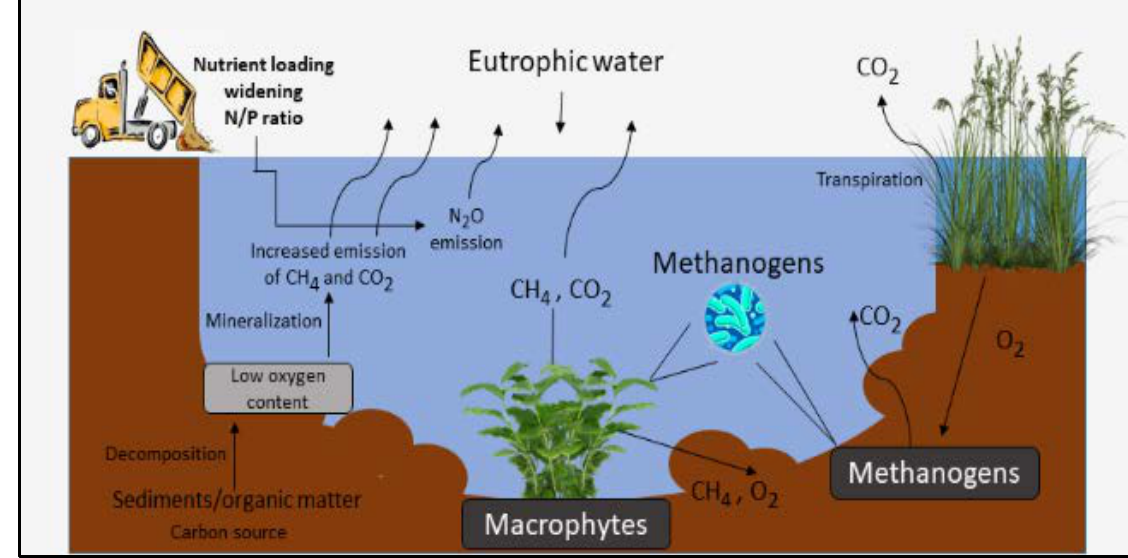
Figure 1. Impact of eutrophication on GHG emissions (Modified figure, source: [41]).